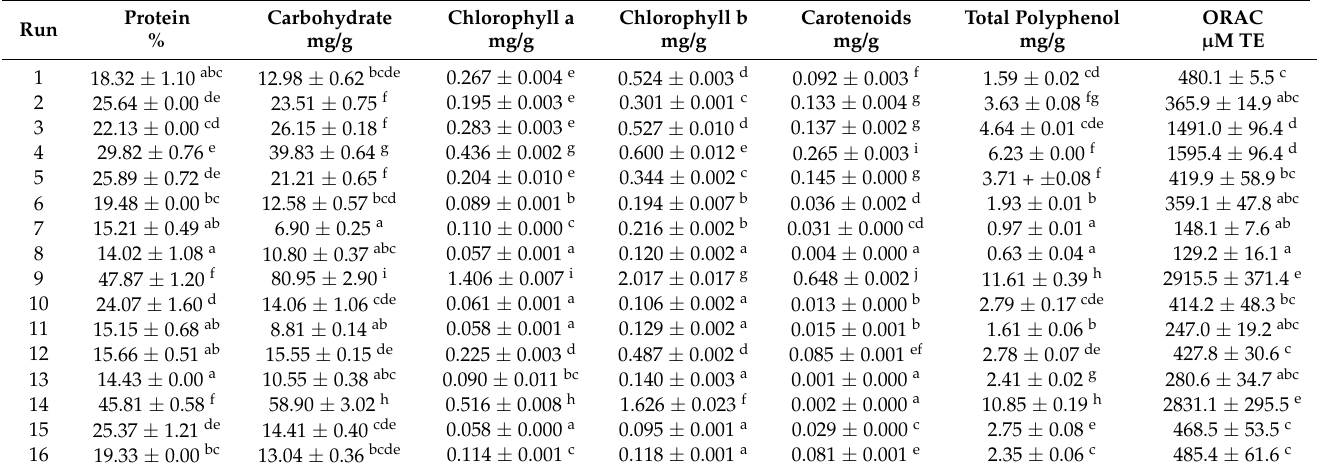
Table 2. Results of bioactive compounds and antioxidant capacity in spirulina extract.